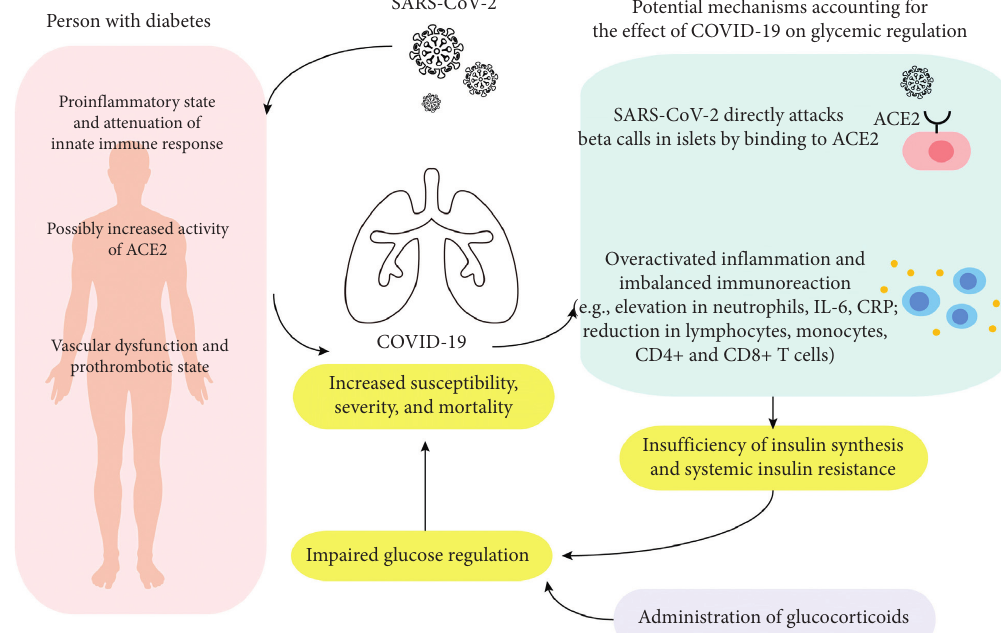
Figure 1: The potential mechanisms for the interaction between COVID-19 and diabetes. Abbreviations: SARS-CoV-2: severe acute respiratory syndrome coronavirus 2; COVID-19: coronavirus disease 2019; ACE2: angiotensin-converting enzyme 2; RAS: renin-an- giotensin system; CRP: C-reactive